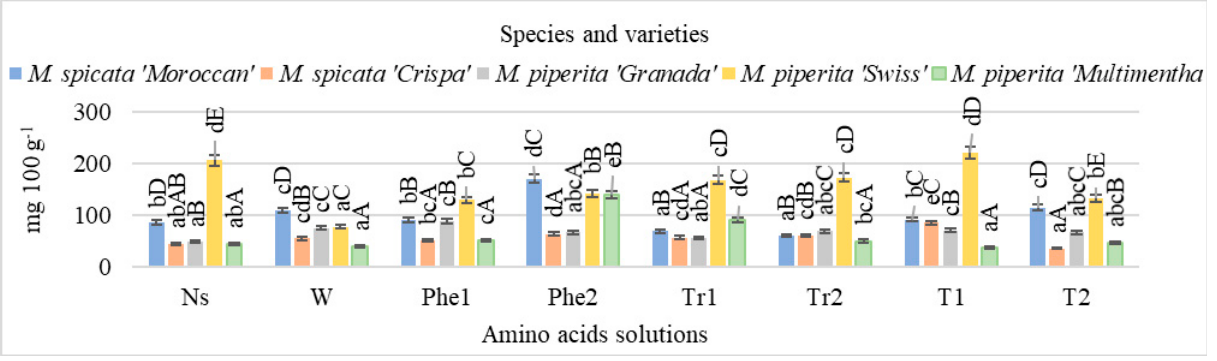
Figure 2. Total flavonoid content in mint influenced by foliar application of amino acids, mg 100 g − 1 DM in 2017–2018 (NS: unsprayed; W: water; Phe1: phenylalanine, 100 mg L − 1 ; Phe2: phenylalanine, 200 mg L − 1 ; Tr1: tryptophane100 mg L − 1 ; Tr2: tryptophane, 200 mg L − 1 ; T1: tyrosine, 100 mg L − 1 ; T2: tyrosine, 200 mg L − 1 ; means marked with different uppercase letters (A, B, C…) indicate significant difference between varieties at p < 0.05; means marked with different lowercase letters (a, b, c…) indicate significant difference between foliar application with amino acids at p < 0.05).